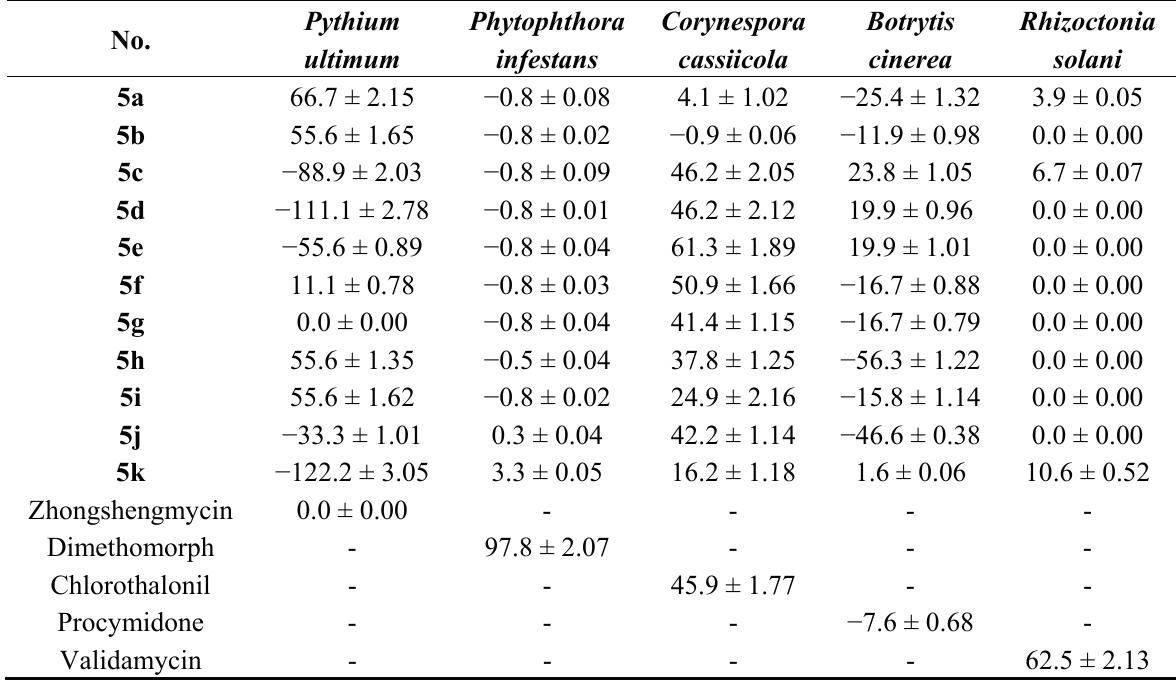
Table 2. The antifungal activity of title compounds in vivo at 100 ppm